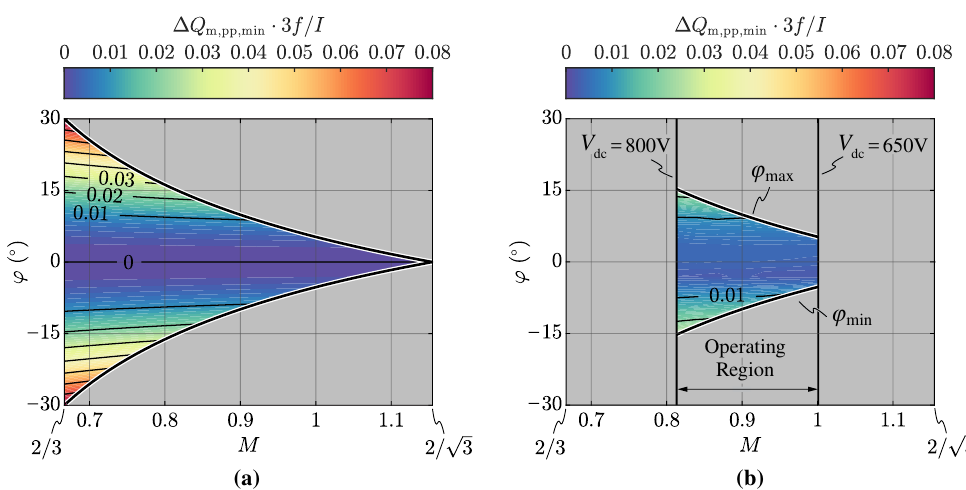
Figure 10. Minimum DC-link mid-point charge ripple ∆ Q m,pp,min (i.e., normalized with respect to the peak phase current I and three-times the grid frequency 3 f ) for 2 / 3 ≤ M ≤ 2 / results and ( b ) experimental results, limited to the operating region of the rectifier prototype (see Section